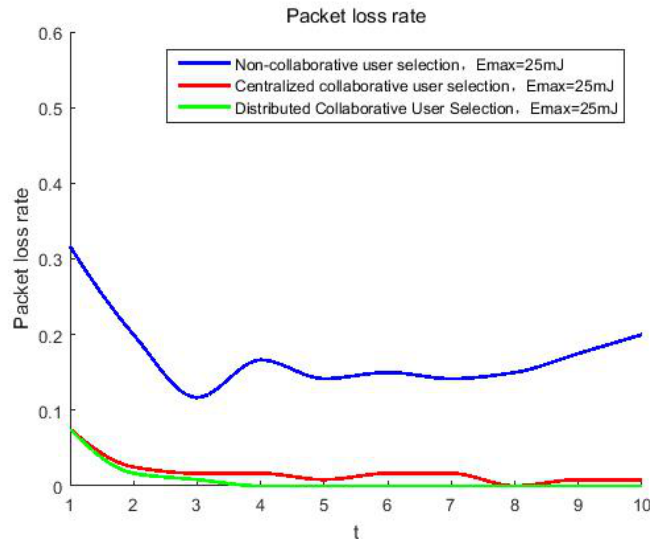
Figure 6. Packet loss rate under different sensing schemes.